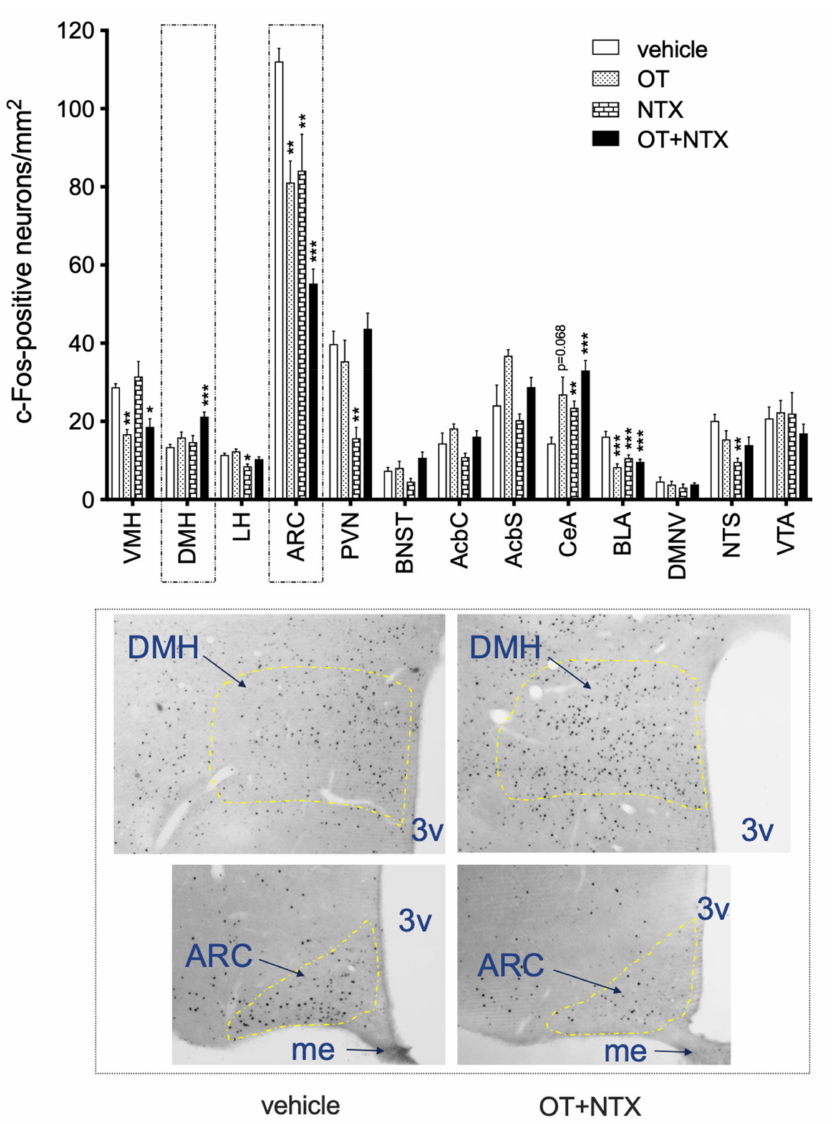
Figure 6. c-Fos immunoreactivity in feeding-related brain areas in rats injected IP with saline, 0.1 mg/kg OT, 3 mg/kg NTX, or 0.1 mg/kg OT + 3 mg/kg NTX. * − p < 0.05; ** − p < 0.01; *** − p < 0.001 (significantly different from saline controls). Photomicrographs depict the dorsomedial (DMH) and arcuate (ARC) nuclei in animals treated with vehicle (saline) and OT + NTX. 3v—third ventricle, me—median